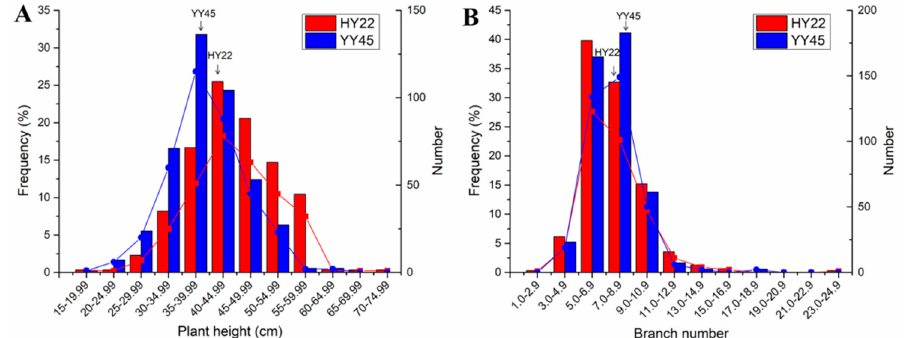
Figure 3. Frequency and number distribution of agronomic traits of M2 generation of HY22 and YY45 induced by EMS treatments. ( A ) Plant height; ( B ) Number of branches.